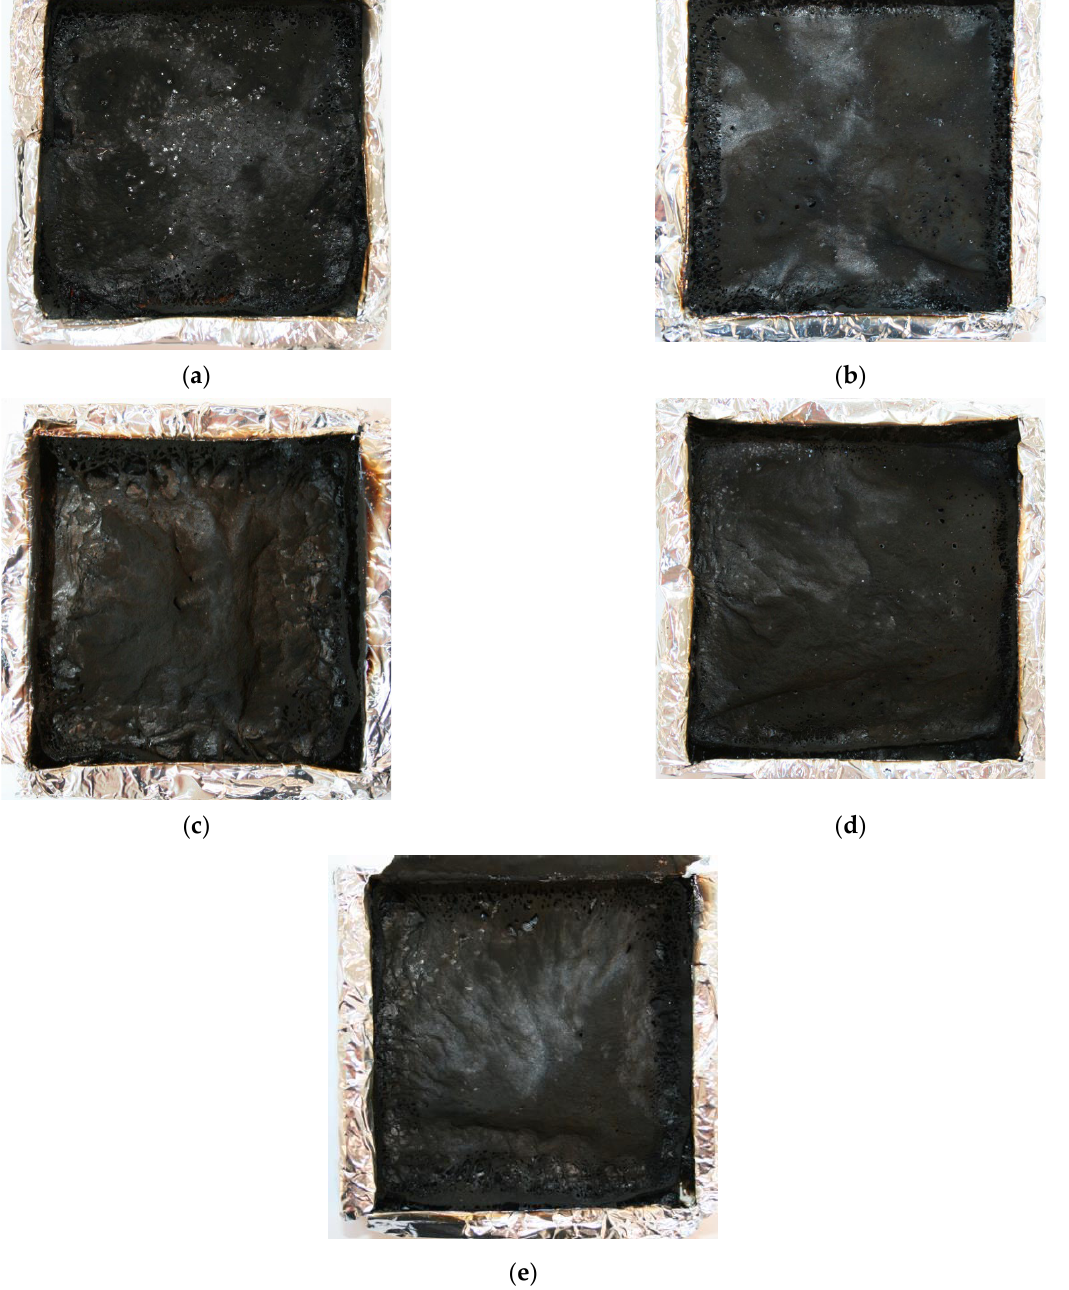
Figure 12. Photographs of samples after cone calorimetry tests ( a ) PUR, ( b ) PUR3W, ( c ) PUR9W, ( d ) PUR15W, ( e ) PUR15WO.